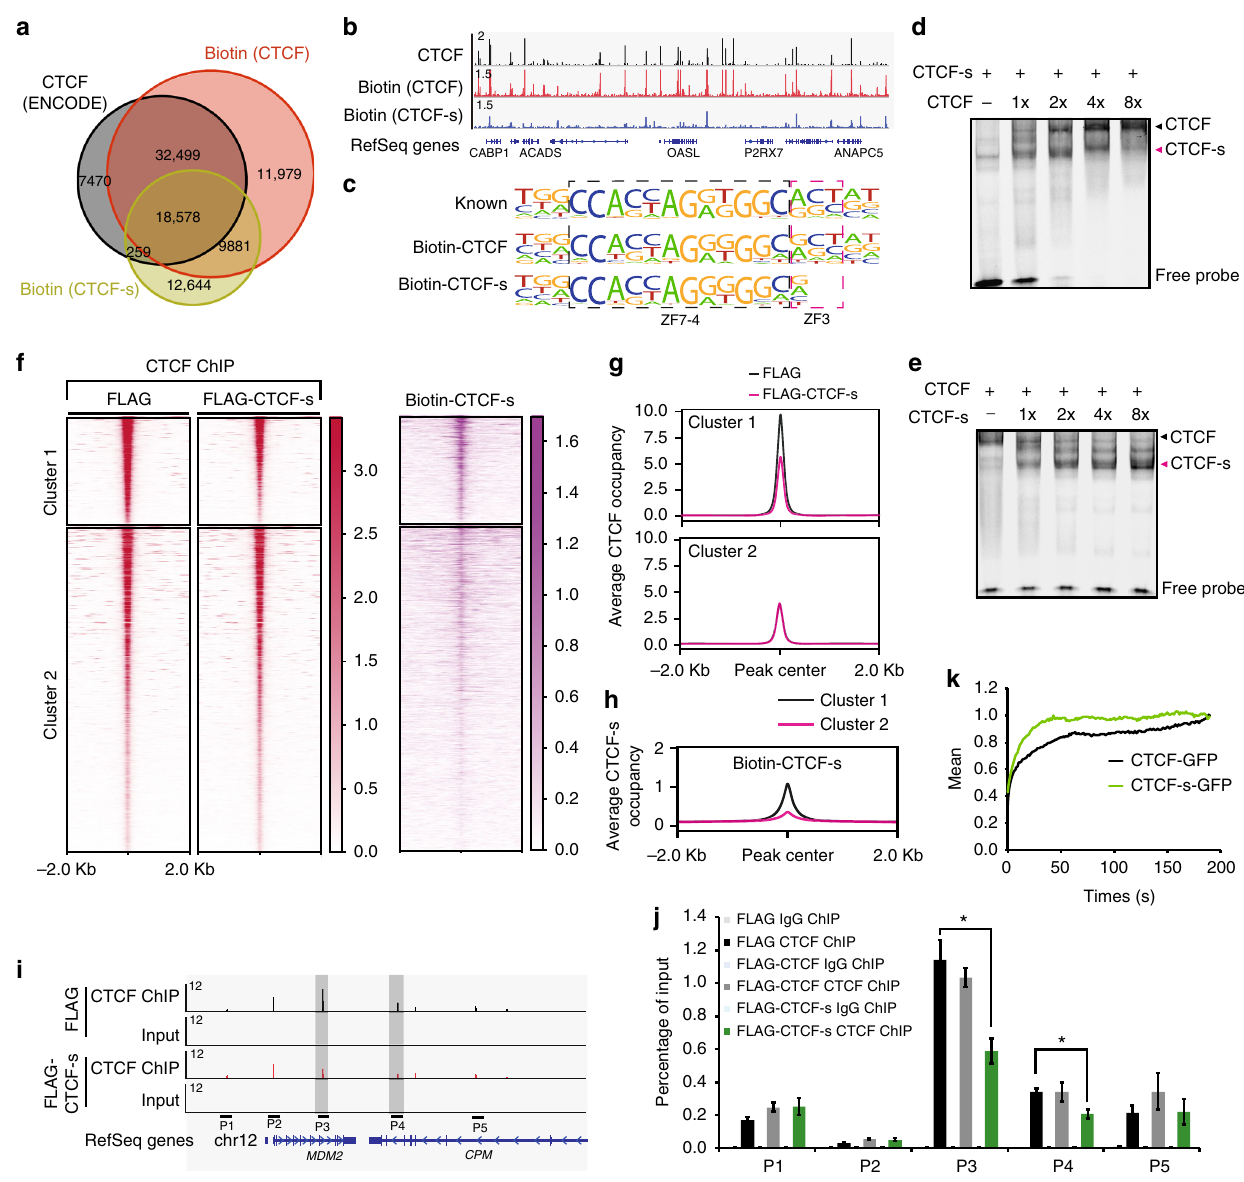
Fig. 2 CTCF-s has its speci fi c genomic binding but also competes with CTCF in binding to their common targets. a Venn diagram showing the overlap of biotin-enriched CTCF or CTCF-s peaks with a normal CTCF ChIP-seq from ENCODE (GSE33213). b Genomic views of ChIP-seq intensities of CTCF (ENCODE), biotin ChIP-seq for biotin-CTCF and biotin-CTCF-s in HeLa-S3 cells at chromosome 12:121,055,606 − 121,842,881. c Consensus DNA binding motif generated from de novo motif discovery. The motif inside the black dotted box is bound by ZF4-7 of CTCF and the motif inside the magenta dotted box is bound by ZF3 of CTCF. d Electrophoresis mobility shift analysis (EMSA) showing DNA binding ability of CTCF and CTCF-s as the concentrations of CTCF increase. e EMSA showing DNA binding ability of CTCF and CTCF-s with increasing amounts of CTCF-s. f Heatmap showing the comparison of CTCF binding occupancies between FLAG control and FLAG-CTCF-s overexpression. Cluster 1 shows the signi fi cantly reduced occupancy of CTCF after CTCF-s overexpression; Cluster 2 shows no difference in the levels of CTCF genomic occupancy with or without CTCF-s overexpression. Heatmap on the right showing the biotin ChIP-seq signal for CTCF-s. g Tag density pileup for all CTCF peaks from clusters 1 and 2, respectively. h Tag density pileup for biotin-CTCF-s peaks from clusters 1 and 2, respectively. i Genomic view showing ChIP primers P1 − P5 at MDM2-CPM loci in chromosome 12. Peaks marked by gray box represent two decreased CTCF peaks upon CTCF-s gain-of-function. j Veri fi cation of CTCF ChIP-seq data in chromosome 12 using ChIP-qPCR. IgG was used as a negative control. The locations of the primer pairs P1 − P5 are indicated in panel ( i ). The data were represented as mean ± s.d. ( n = 3 technological repeats) with the indicated signi fi cance by using a two-tailed Student ’ s t test (* p < 0.05). The entire experiment was performed three